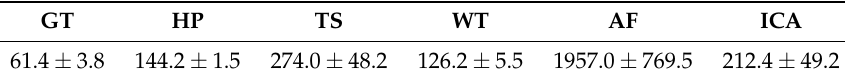
Table 3. Execution time of different methods